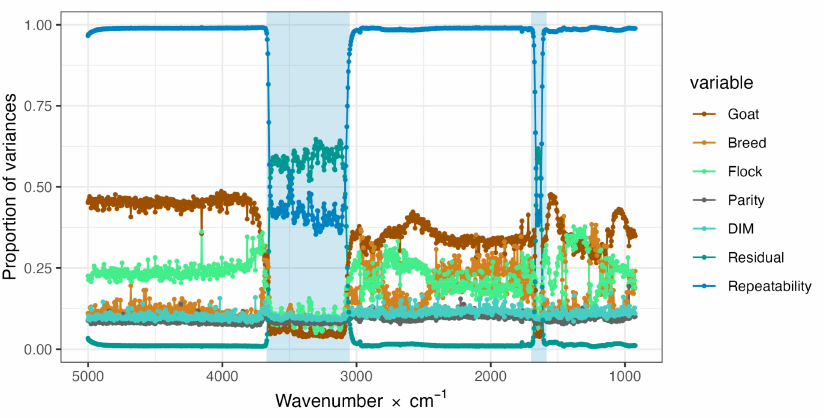
Figure 2. Sample/goat repeatability and proportions of variances for Goat, Breed, Flock, Parity, Days in Milk (DIM), and the residual term for the absorbance values of each of the 1060 wavenum- bers